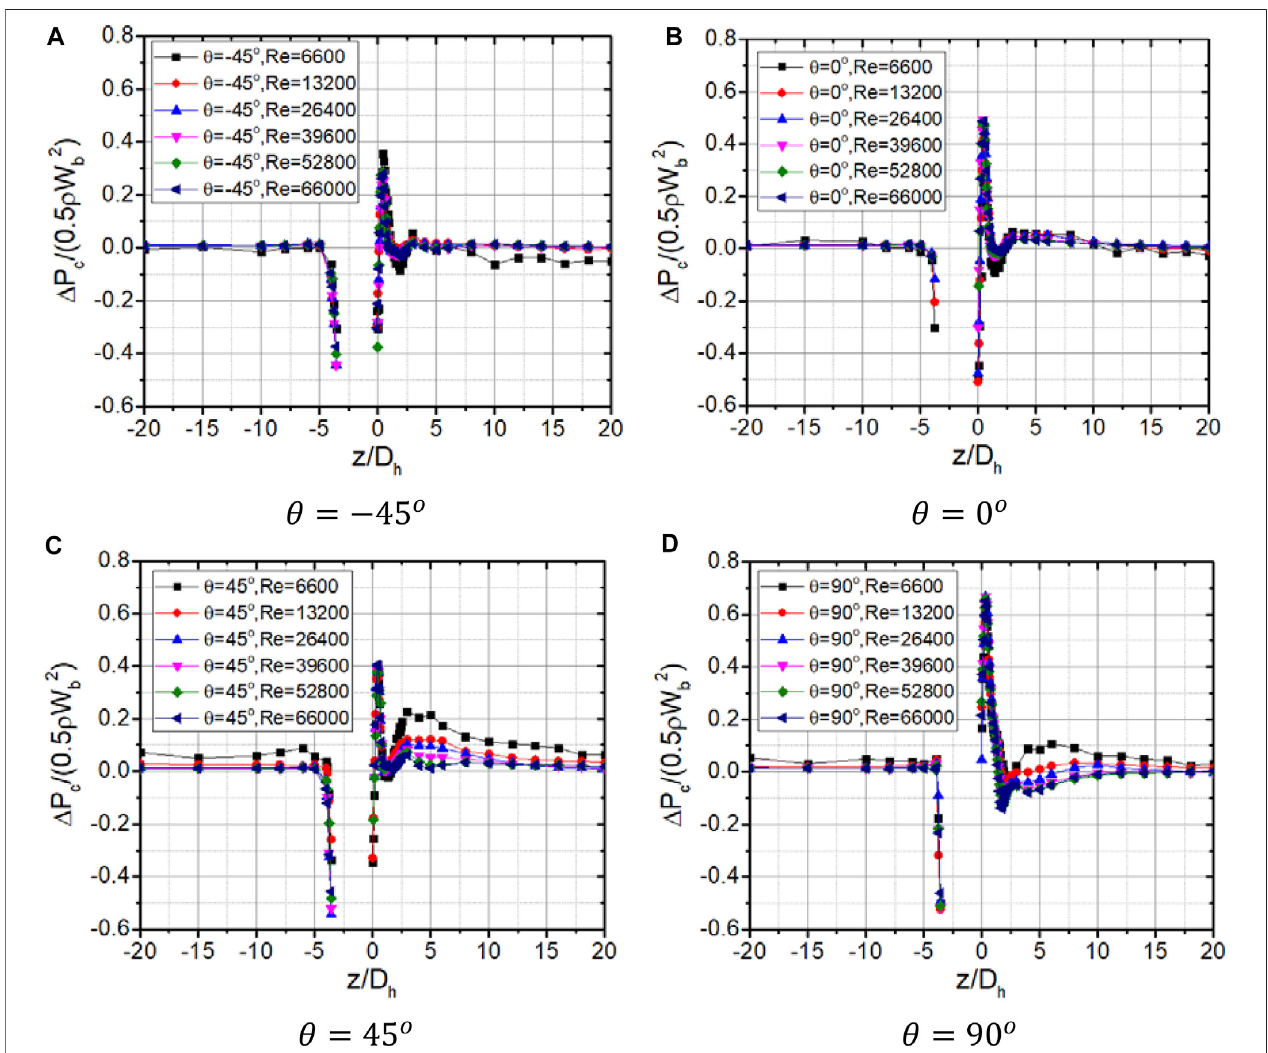
FIGURE 9 | Typical normalized lateral pressure loss from − 20D h to 20D h